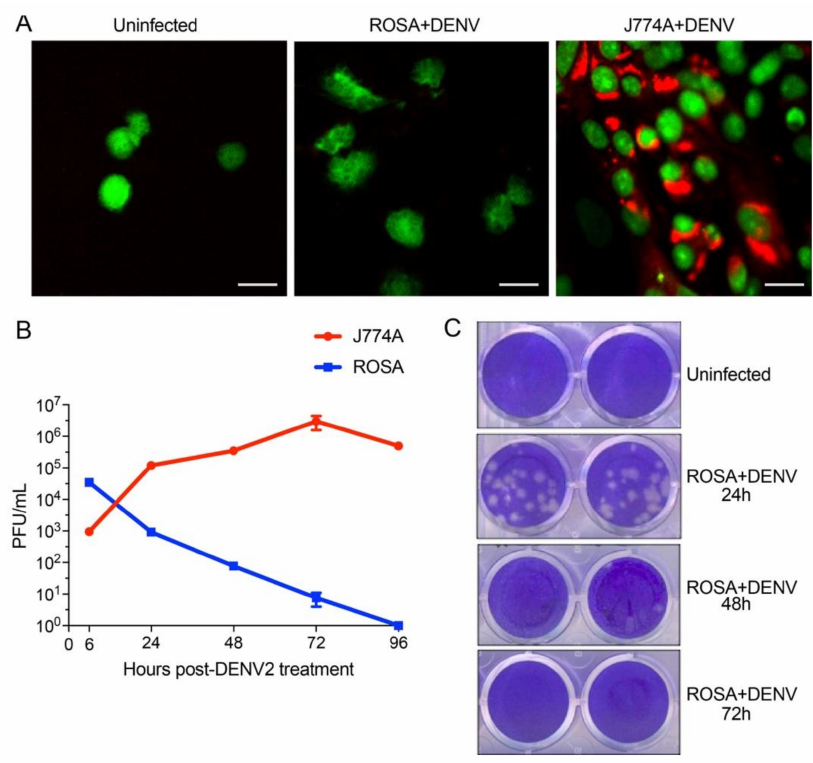
Figure 2. huMCs are not productively infected by DENV. ( A ) Images of control ROSA cells, DENV-exposed ROSA cells, and DENV-permissive macrophage (J774A) cells 48 h after exposure to DENV. Cells were stained for nuclear DNA (green) and DENV Env protein (red). Accumulation of Env protein was only visually apparent in the positive-control macrophage cells. ( B ) Kinetics of DENV titers in the supernatants of DENV-exposed ROSA and J774A cells, quantitated by plaque-forming assay. Error bars represent the SEM and are present at all time points, even if not visually discernable. ( C ) Images of representative plaque assay duplicates after titering of supernatants from ROSA-exposed MCs at various time points are shown. Residual input virus plaques were observed at early time points and decreased over the course of incubation. Productive replication of DENV was not observed in